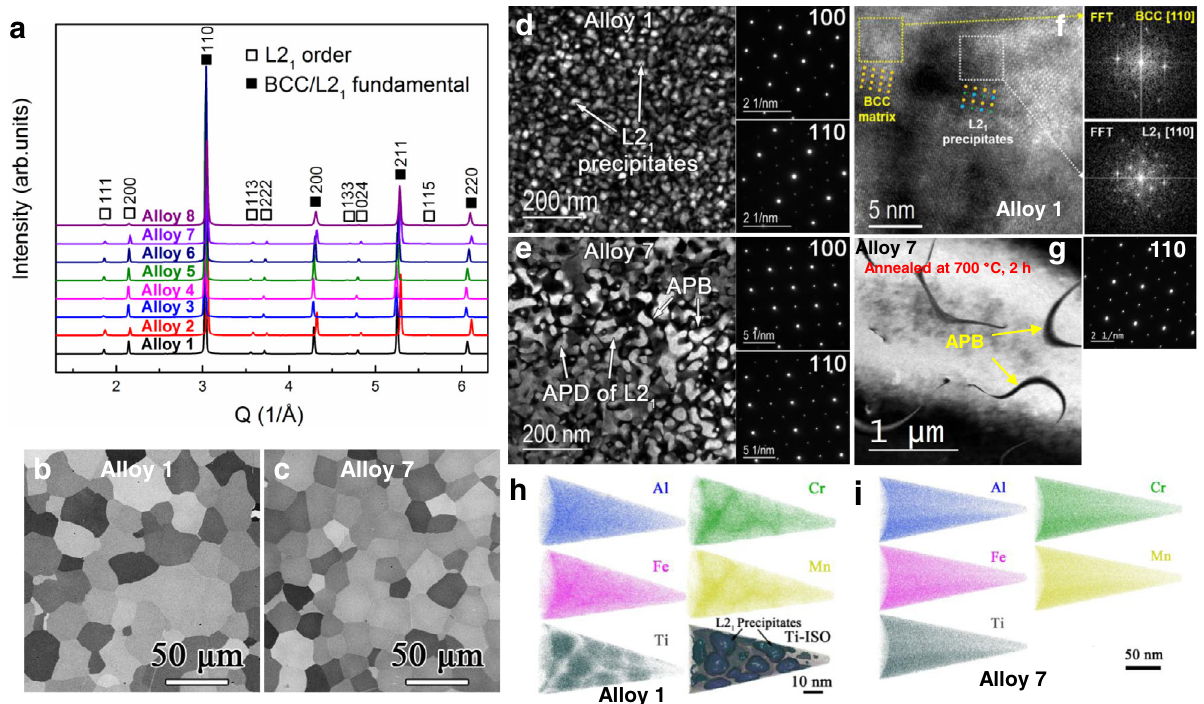
Fig. 2 Microstructural information of the discovered LWHEAs. a Synchrotron XRD patterns of Alloys 1 – 8 in their as-cast states. b , c Backscattered electron (BSE) images of the representative Alloys 1 (Al 20 Cr 5 Fe 50 Mn 20 Ti 5 ) and 7 (Al 30 Cr 5 Fe 50 Mn 10 Ti 5 ), representatively. d , e The TEM DF images taken by the unique (111) re fl ection of the L2 1 phase and the corresponding selected-area diffraction (SAED) patterns along the [100] and [110] zone axes of Alloys 1 and 7 in their as-cast states, respectively. The arrows indicate the features of precipitates, antiphase domain (APD), and antiphase boundary (APB). f High-resolution TEM (HRTEM) image of Alloy 1 taken along the [110] zone axis, showing the coherent interfaces between the BCC matrix and the L2 1 nanoscale precipitates. The next two images are the fast Fourier Transform (FFT) patterns of the BCC matrix and L2 1 precipitates of Alloy 1. g The TEM DF images taken by the unique (111) re fl ection of the L2 1 phase of the Alloy 7 after annealing at 700 °C for 2 h, showing the greatly grown APDs. h , i APT atomic maps of Alloys 1 and 7,